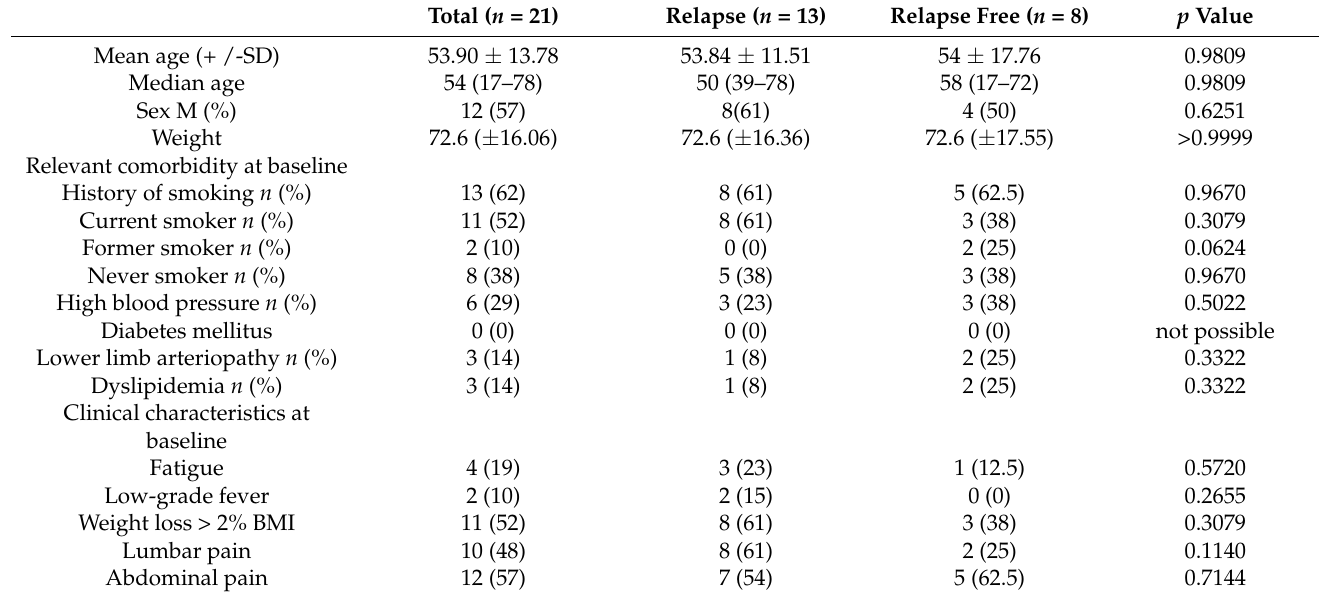
Table 1. Characteristic of patients at diagnosis.